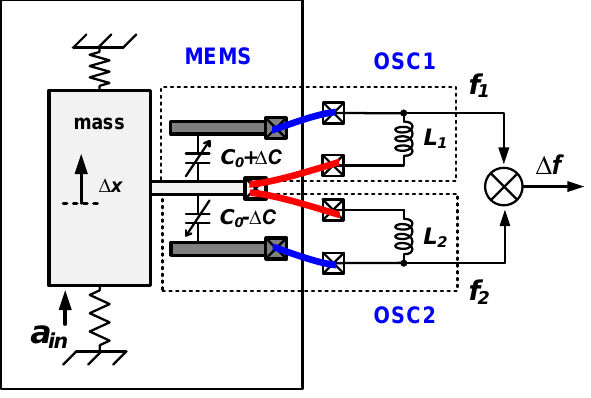
Figure 3. Illustration of proof mass connection in micromechanical LC